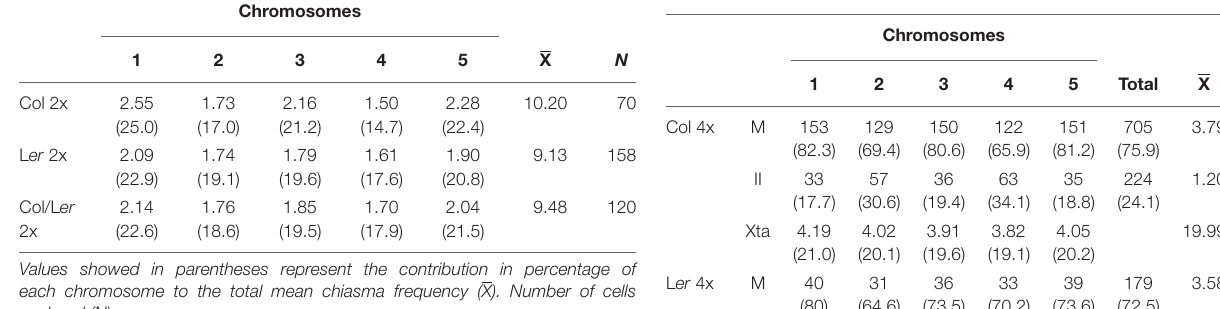
TABLE 2 | Multivalents (M), bivalent pairs (II) and chiasma frequency (Xta) observed for the different chromosomes (1–5) in PMCs from Col, L er, and Col/L er autotetraploid